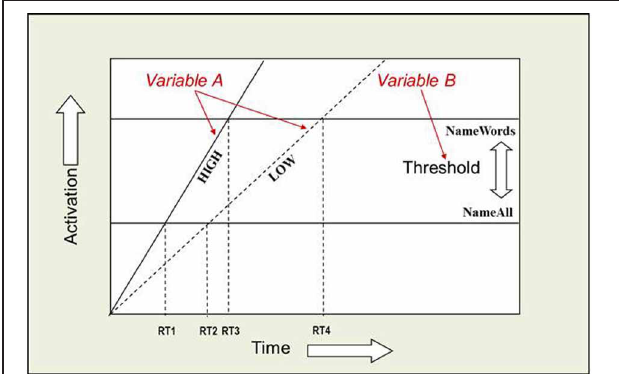
FIGURE 2 | Over-additive interaction between INST and WF. An Additive Factors Method interpretation of this interaction is that both INST and WF are affecting a common system in time. If INST are assumed to affect the threshold for activation, and WF is assumed to affect the rate of activation over time, or vice versa, then the points in time when each rate crosses a threshold correspond to the average onset RTs. [(RT4 − RT2) > (RT3 − RT1)] and [((RT2 + RT4)/2) > ((RT1 + RT3)/2)]. WF and WT interact in a similar